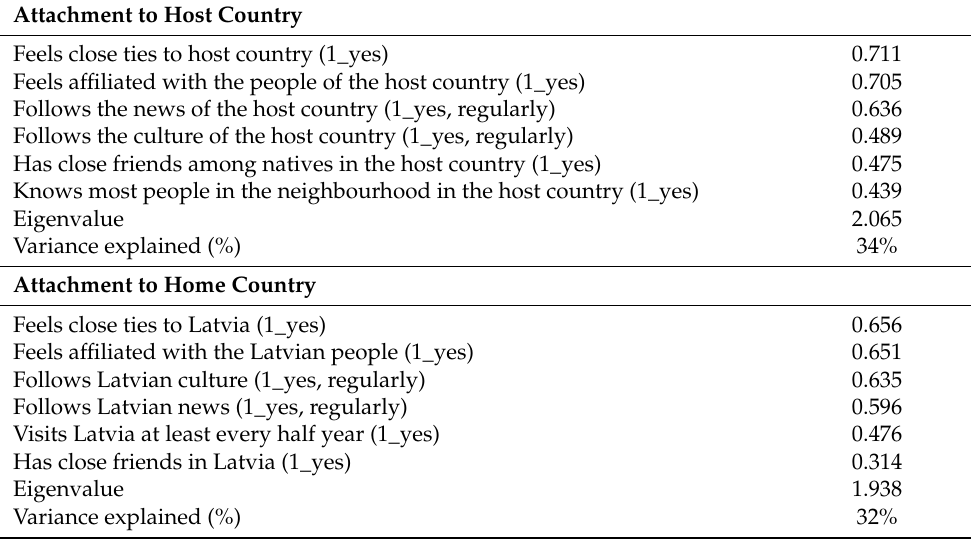
Table 3. Empirical measures of attachment to the host country and home country (factor